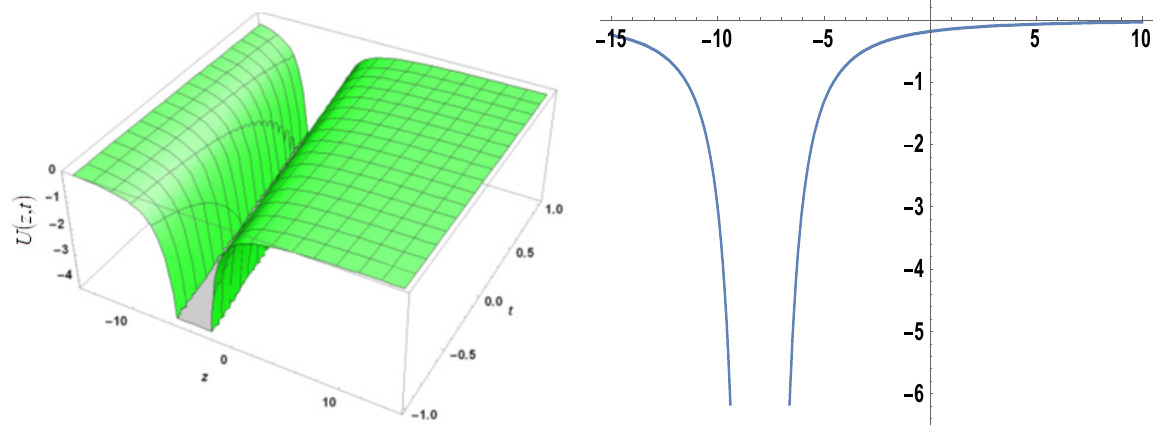
Figure 15. The 3D and 2D plots of Equation (65) for various values of parameters.